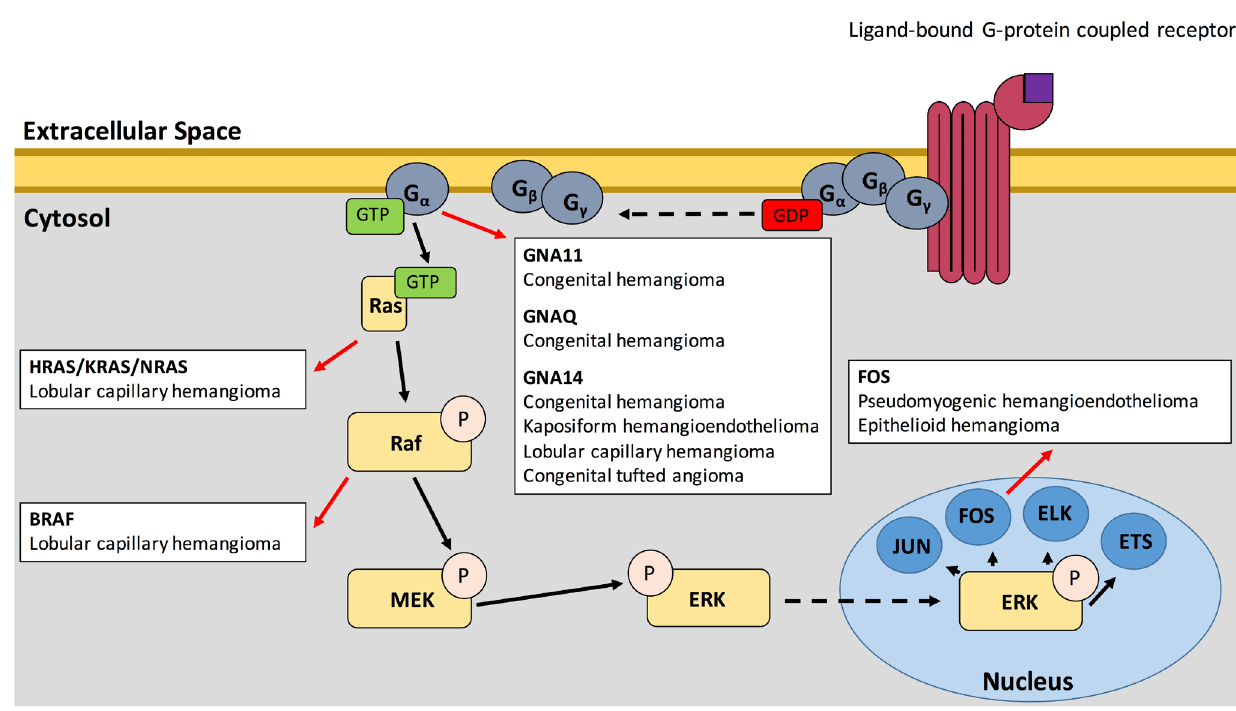
Figure 1. Positions of the Ras-MAPK pathway wherein mutations have been demonstrated to lead to childhood vascular tumors (red arrows). Unbroken arrows indicate activation while broken arrows indicate